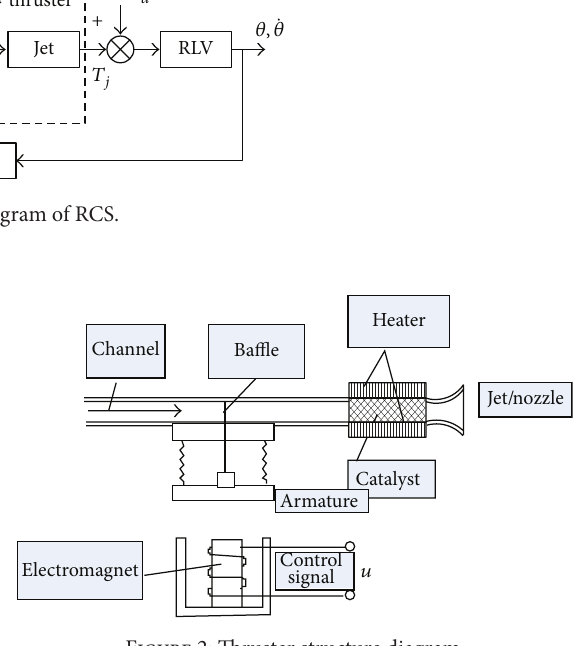
Figure 2: Thruster structure